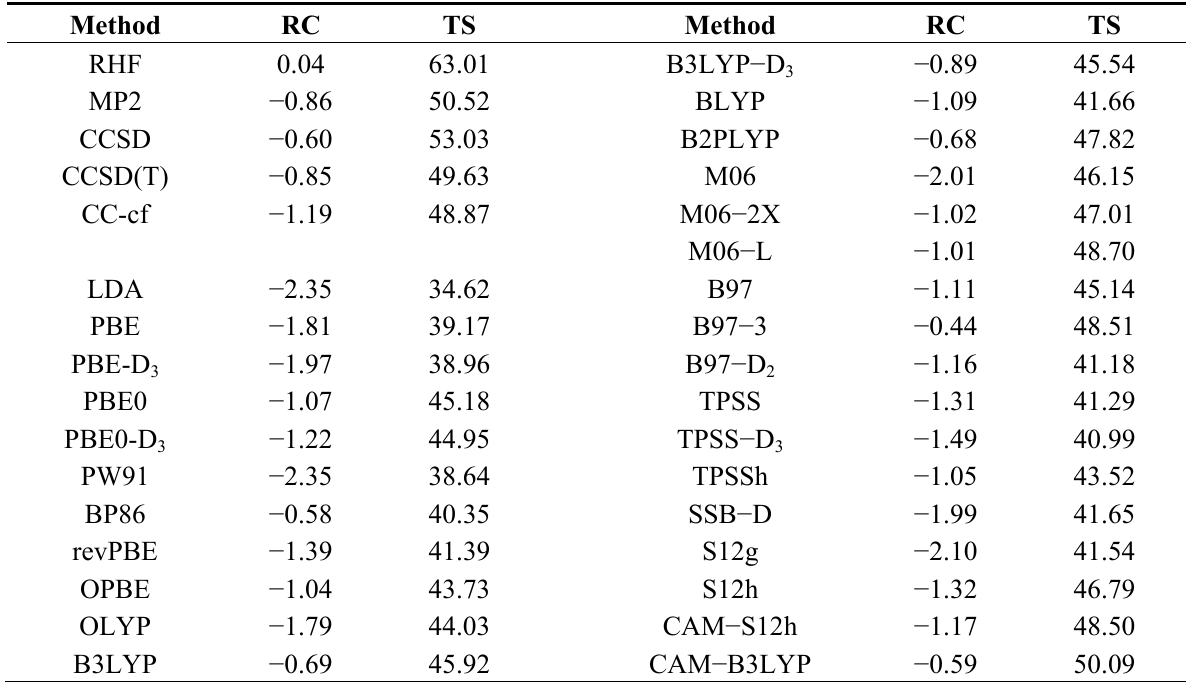
Table 3. Energy profile (aqz basis, kcal·mol − 1 ) using single − point calculations at CCSDT/atz